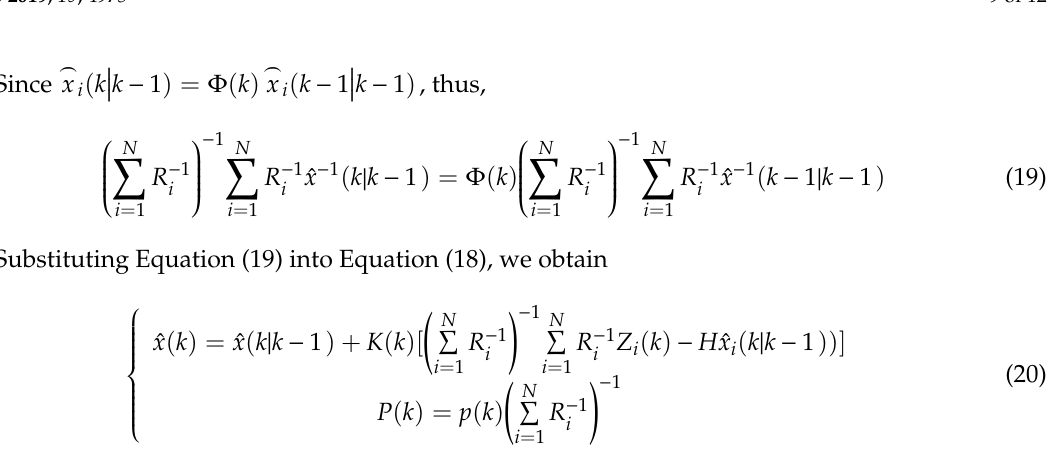
Figure 7. Observed track and actual track.